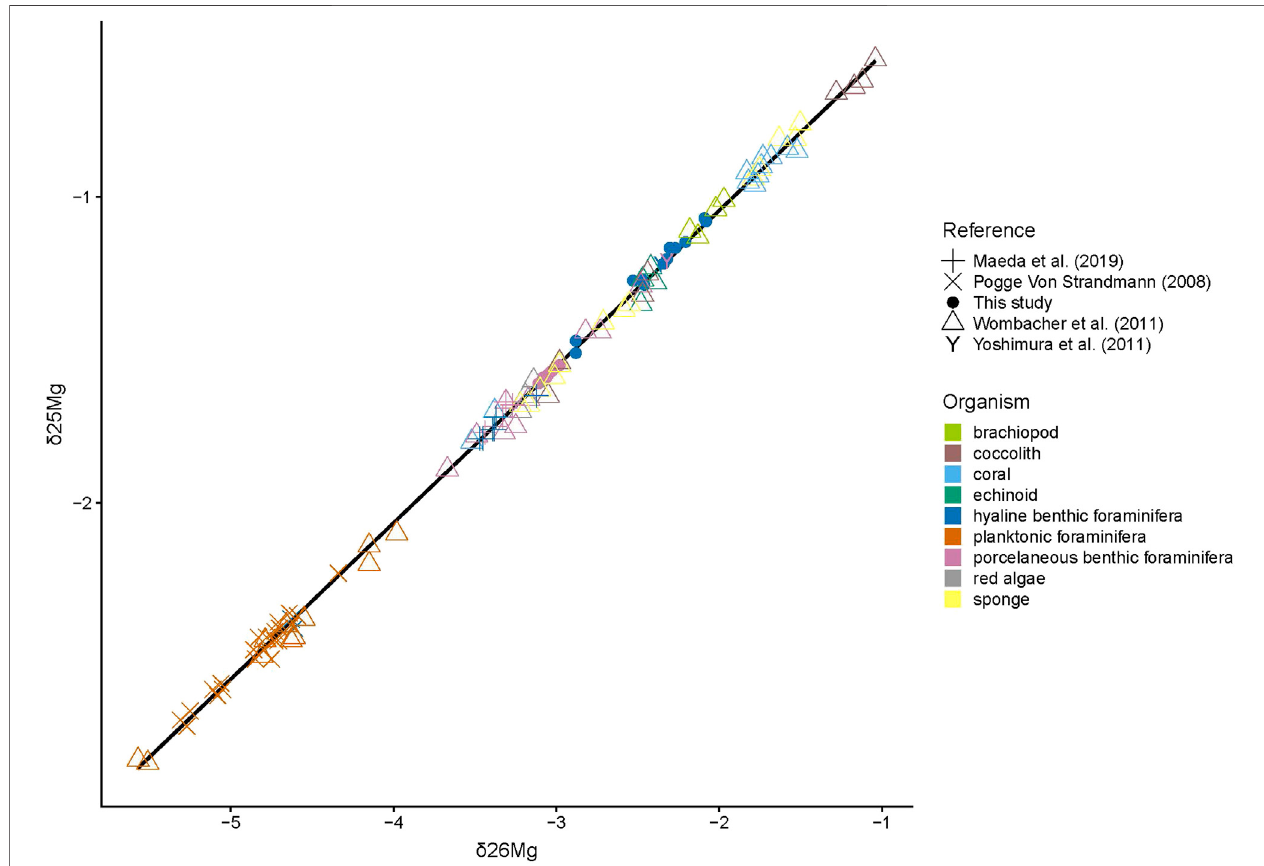
FIGURE 1 | The relationship between δ 25 Mg and δ 26 Mg values in our dataset combined with published data from other biogenic carbonates (Pogge von Strandmann, 2008; Wombacher et al., 2011; Yoshimura et al., 2011; Maeda et al., 2019) can be described as δ 25 Mg (cid:2) 0.510* δ 26 Mg − 0.024 ( p value < 2e − 16; R 2 (cid:2)